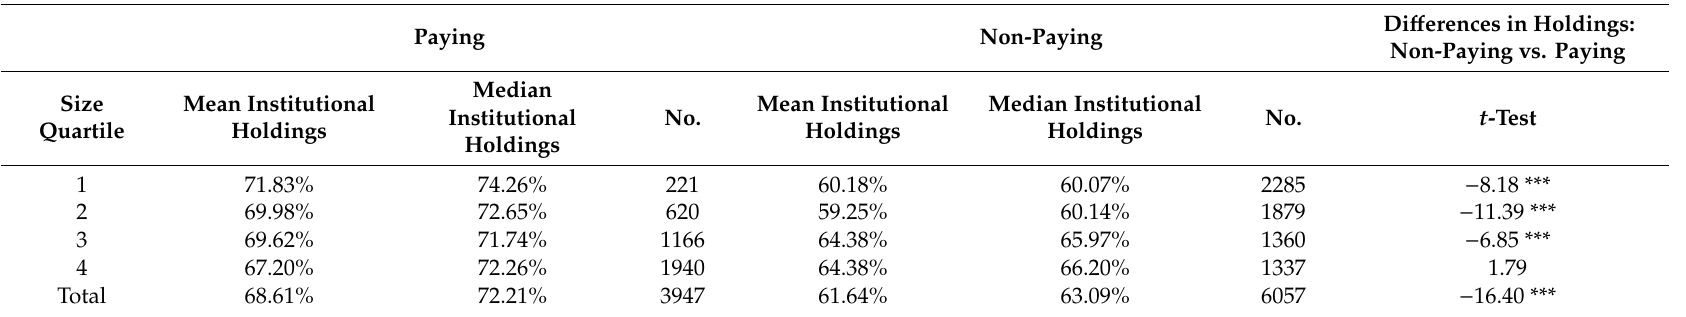
Table 2. Institutional Ownership and Dividend Payout. The data consist of publicly held Australian firms between 2001 and 2015 with information about institutional holdings and market value, excepting utility and financial companies. We obtain the top 20 Institutional-holdings data from SIRCA In Panel A, firms in each group are divided annually into those that pay dividends and those that do not pay dividends. The statistics in Panel A are for di ff erences in means of institutional holdings between the size group that pays dividends and the size group that does not pay dividends. In Panel B, firms that pay dividends are divided annually into quartiles based on their dividend-to-book ratio. Groups are then aggregated across years and size quintiles. Statistics in Panel B are for di ff erences in means of institutional holdings between the 4th quartile and the 1st quartile of dividend groups. The symbols *, **, *** denote significance at the 10%, 5% and 1% levels,